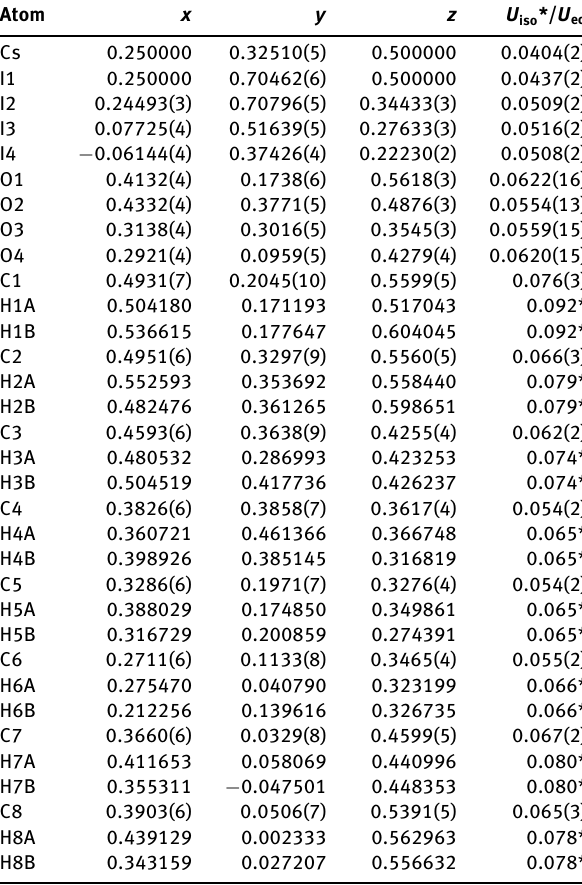
Table 2: Fractional atomic coordinates and isotropic or equivalent isotropic displacement parameters (Å 2